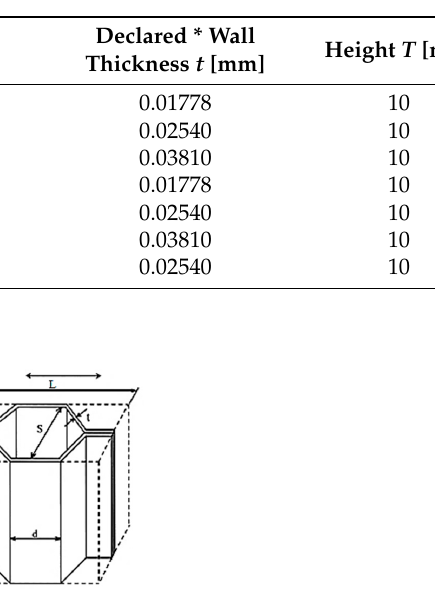
Figure 1. An example of the analyzed honeycomb structure ( left ), and the basic designations of the honeycomb’s structural elements ( right )